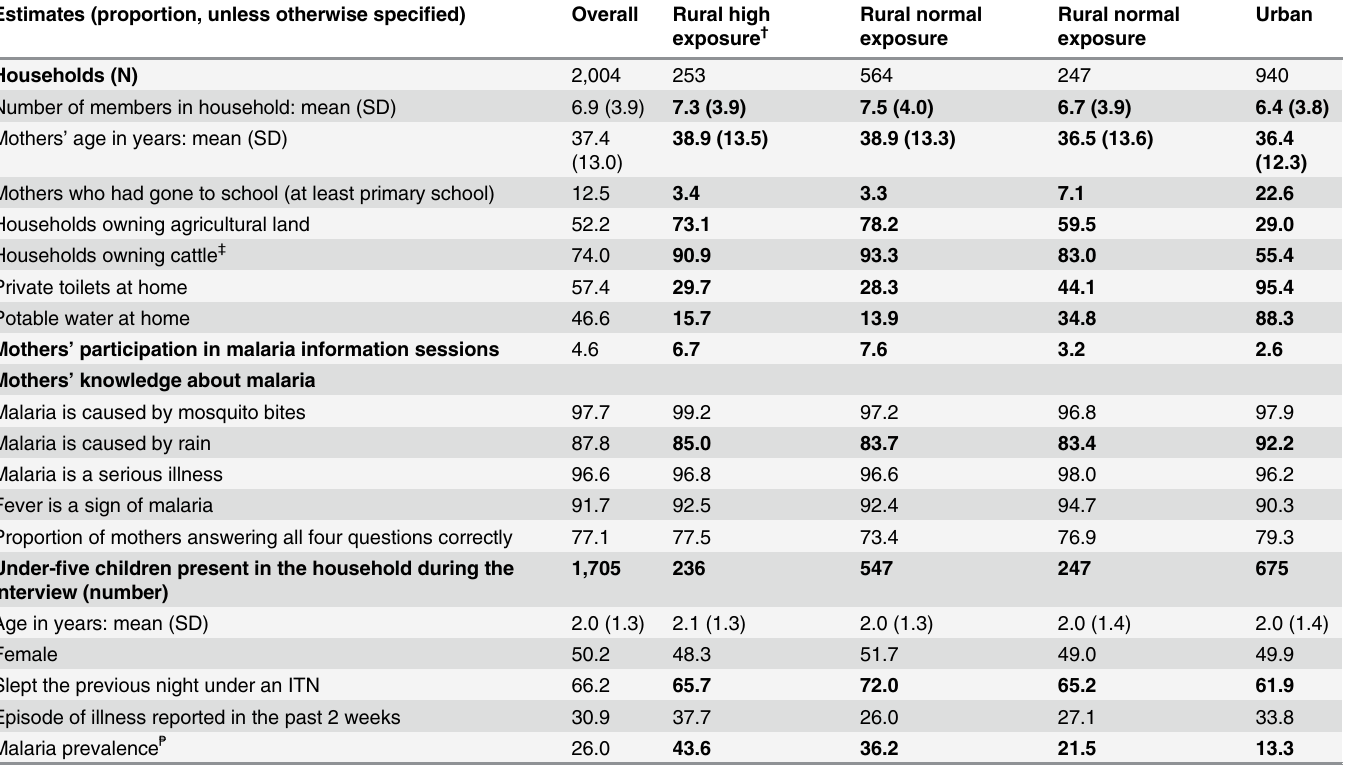
Table 2. Main variables and characteristics of households, mothers and under-five